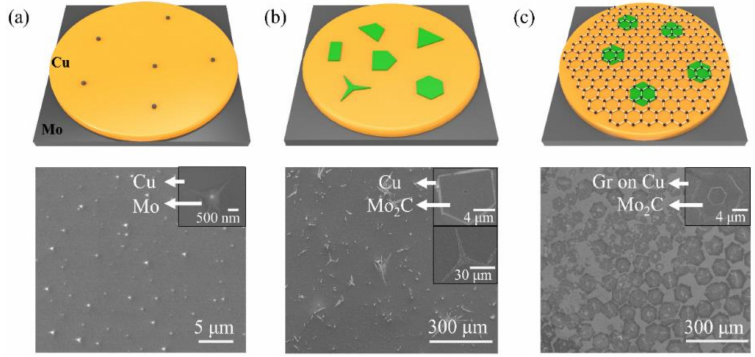
Figure 2. The schematic diagrams ( upper ) and SEM images ( bottom ) of Mo 2 C crystal and Mo 2 C—Gr growth under the various ratios of methane to hydrogen. ( a ) 0, ( b ) 1:600, ( c )